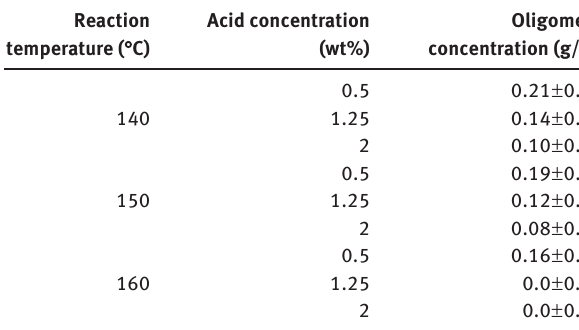
Table 2 Oligomer concentration in